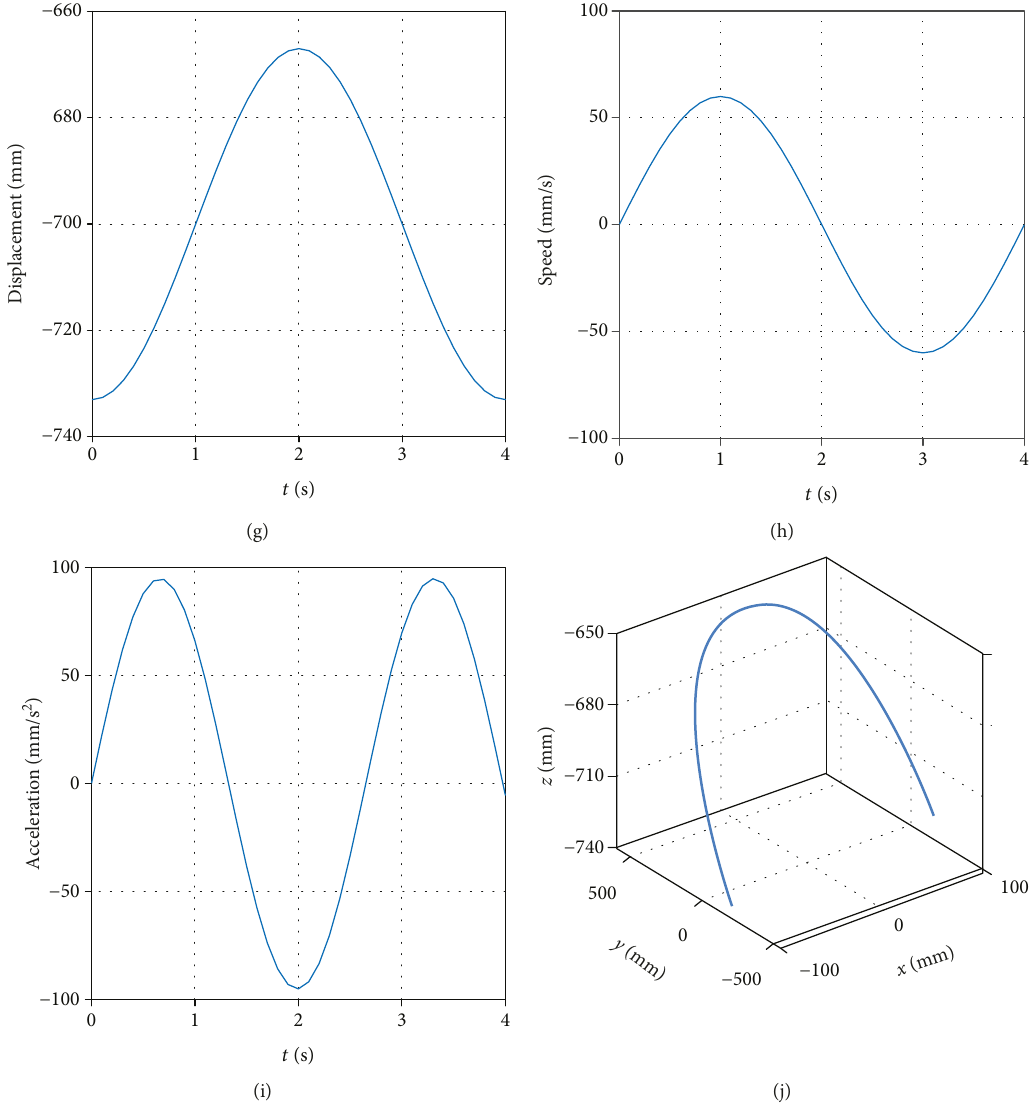
Figure 11: (a) The position of foot in the x direction. (b) The speed of foot in the x direction. (c) The acceleration of foot in the x direction. (d) The position of foot in the y direction. (e) The speed of foot in the y direction. (f) The acceleration of foot in the y direction. (g) The position of foot in the z direction. (h) The speed of foot in the z direction. (i) The acceleration of foot in the z direction. (j) Foot trajectory of swinging